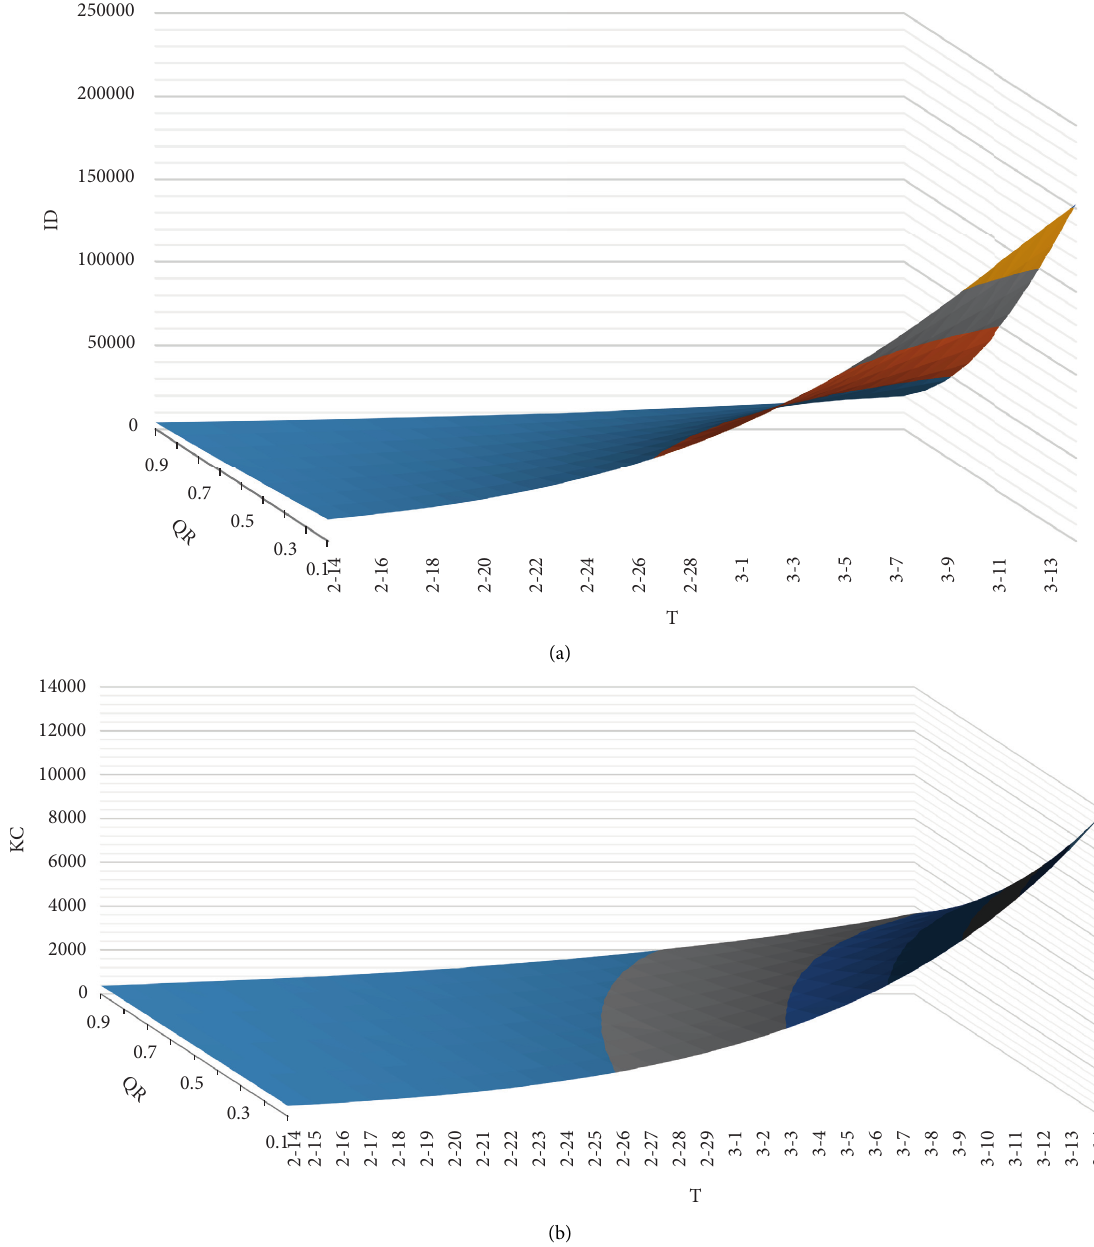
Figure 10: Trend of ID and KC under different